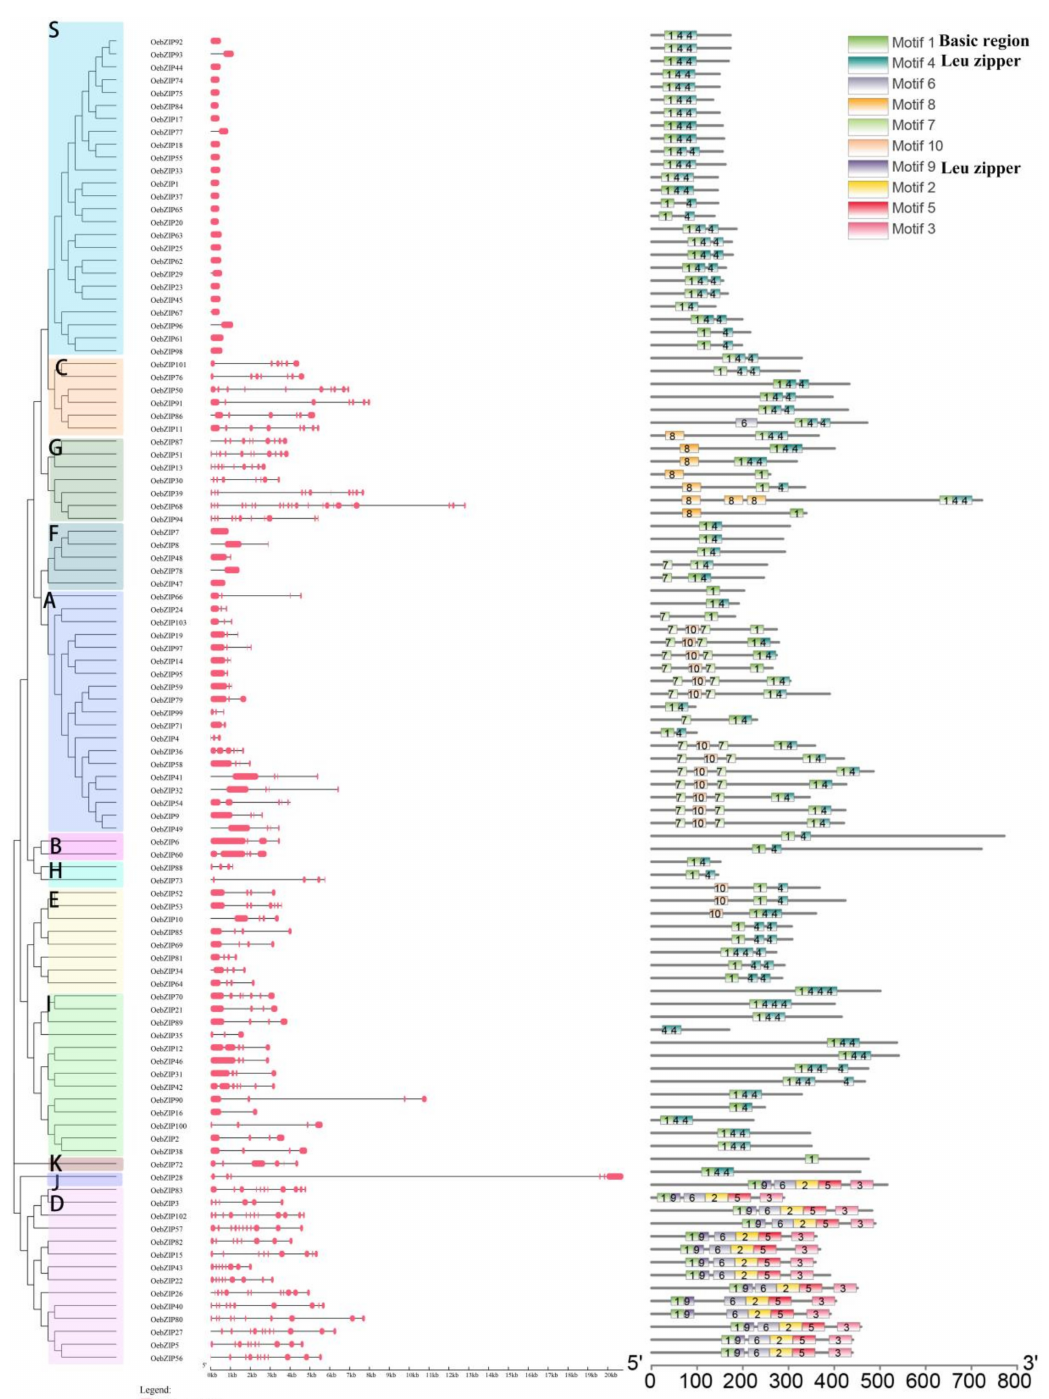
Figure 2. Phylogenetic tree. The distribution of the conserved protein motifs and gene structures of OebZIP genes. Di ff erent color blocks represent di ff erent subgroups. Red boxes indicate exon region, and black lines indicate intron. The motifs are numbered 1–10 and displayed in boxes of di ff erent colors. Motif 1 indicates the basic region of bZIP domain and motifs 4 and 9 indicate a Leu zipper of the bZIP domain. Detailed sequence information for each motif is shown in Figure